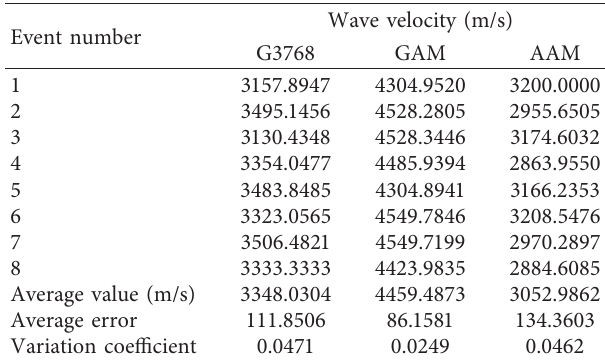
Figure 1: The coordinates of AE sources and sensors of rod-shaped rock. Table 2: Results of wave velocity calibration for each group of rod- shaped rock.